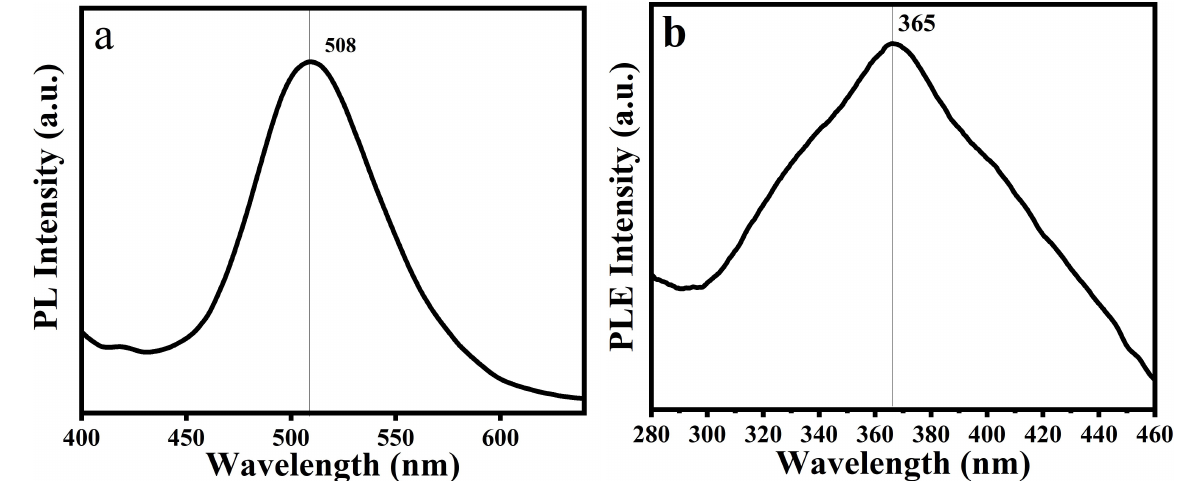
Figure 3. ( a ) photoluminescence spectroscopy (PL) emission spectrogram of SrAl 2 O 4 : 2%Eu 2+ ,0.5%Dy 3+ sample was excited at 365 nm, ( b ) Photo Luminescence Excitation (PLE) ex- citation spectrum of SrAl 2 O 4 : 2%Eu 2+ ,0.5%Dy 3+ sample was detected at 508 nm.